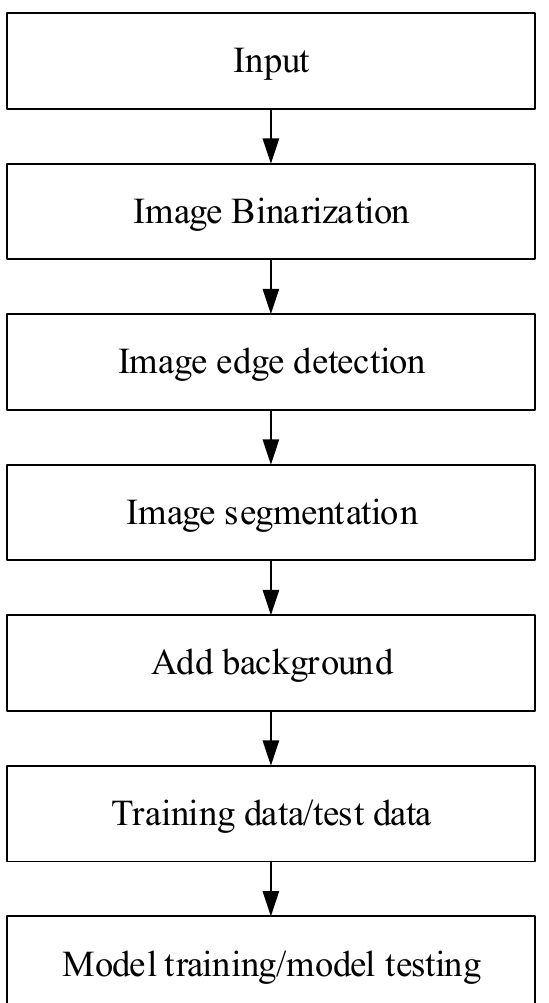
Figure 3. Flowchart for identifying residual oil.